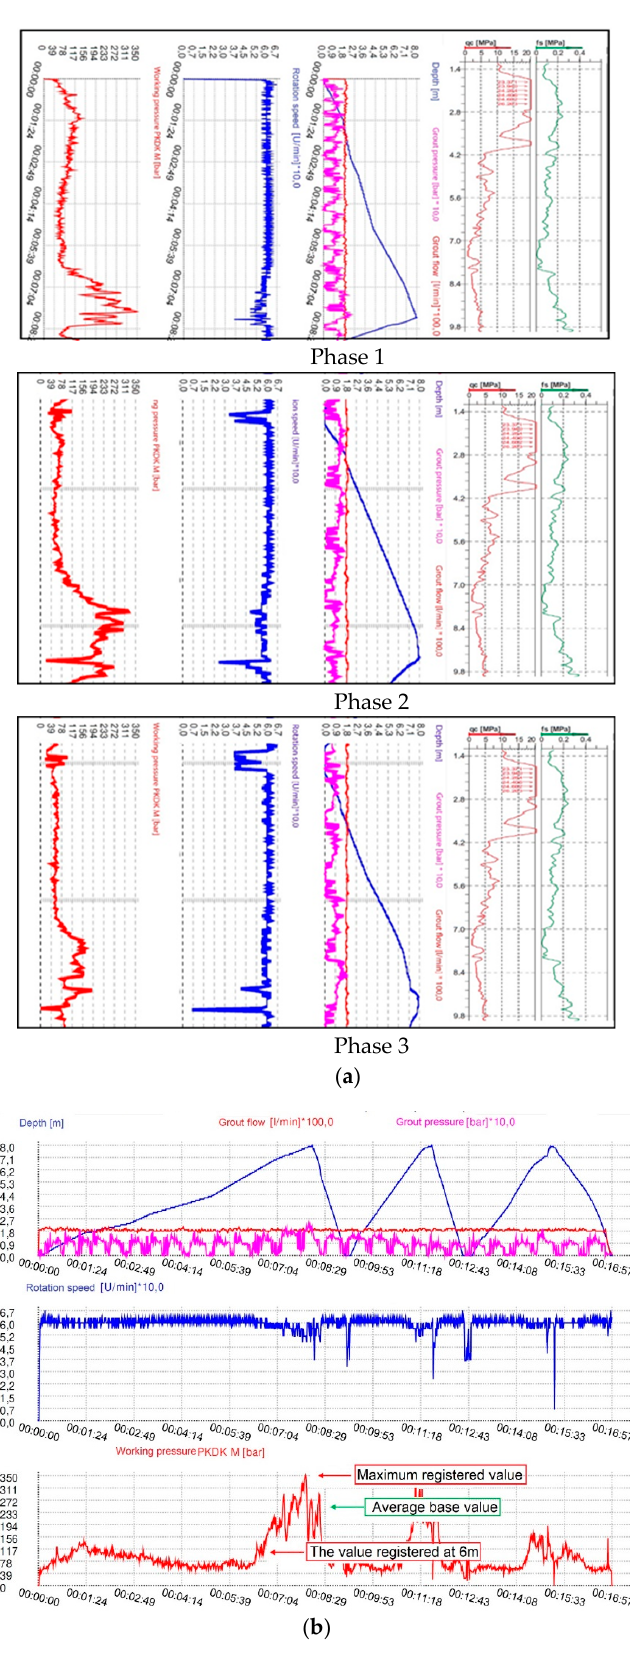
Figure 8. ( a ) Dependence of probe resistance (fs and qc) was presented from the level of the working platform to the level of the depression of the column base in the bearing ground broken down into three phases of mixer penetration; ( b ) Parameters registered by the device during the formation of the 454 representative columns (correlation of q c , f s , and DSM probe working pressure).